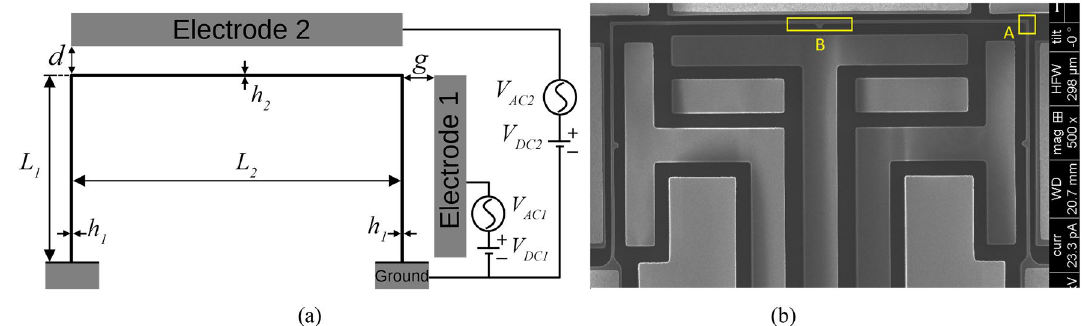
Figure 1. ( a ) Schematic of the micro portal frame with the actuation electrodes; ( b ) Scanning Electron Microscope (SEM) picture of the top view of the fabricated MEMS portal frame made of silicon. Squares A and B are the camera’s targets of the experimental equipment to measure the 1st and 2nd modes, respectively. Square A is set on the end of a column, while square B is set on the mid-span of the supported